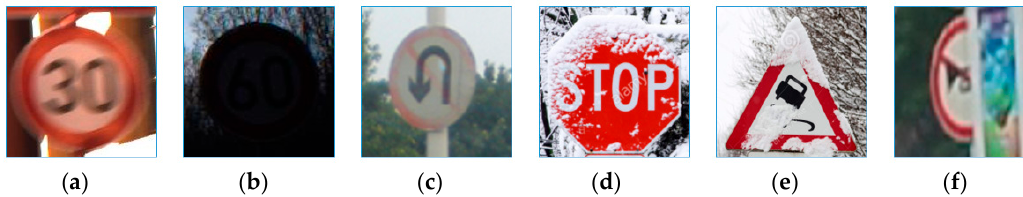
Figure 1. Examples of the unideal traffic sign images: ( a ) motion blur, ( b ) undesirable light, ( c ) color fading, ( d ) and ( e ) snow, ( f ) occlusion.